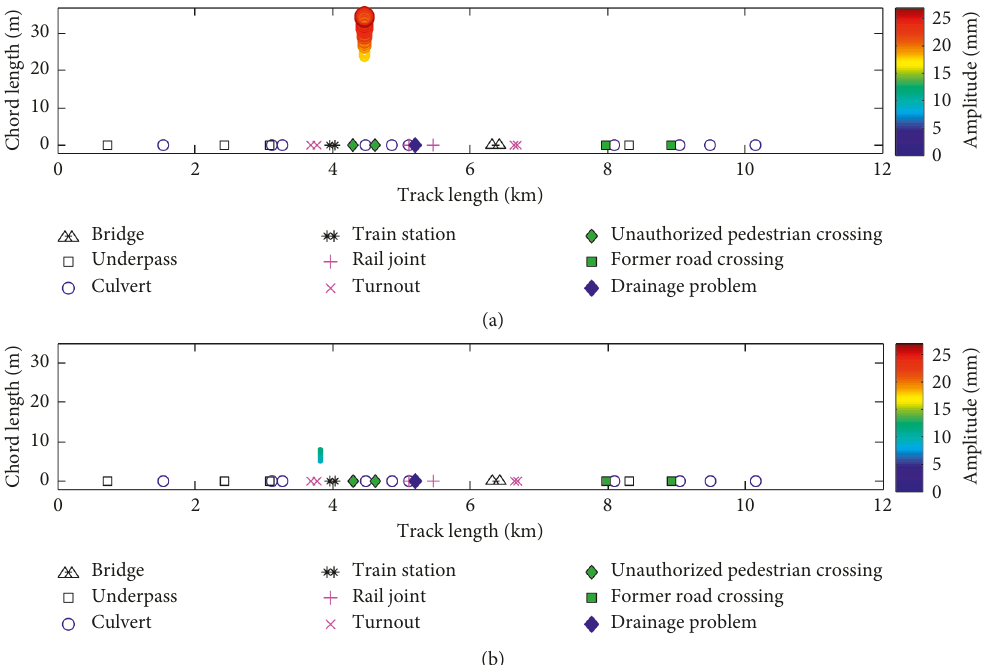
Figure 10: Locations that may be causing (a) significant lower passenger comfort and (b) higher risk of derailment of the train.